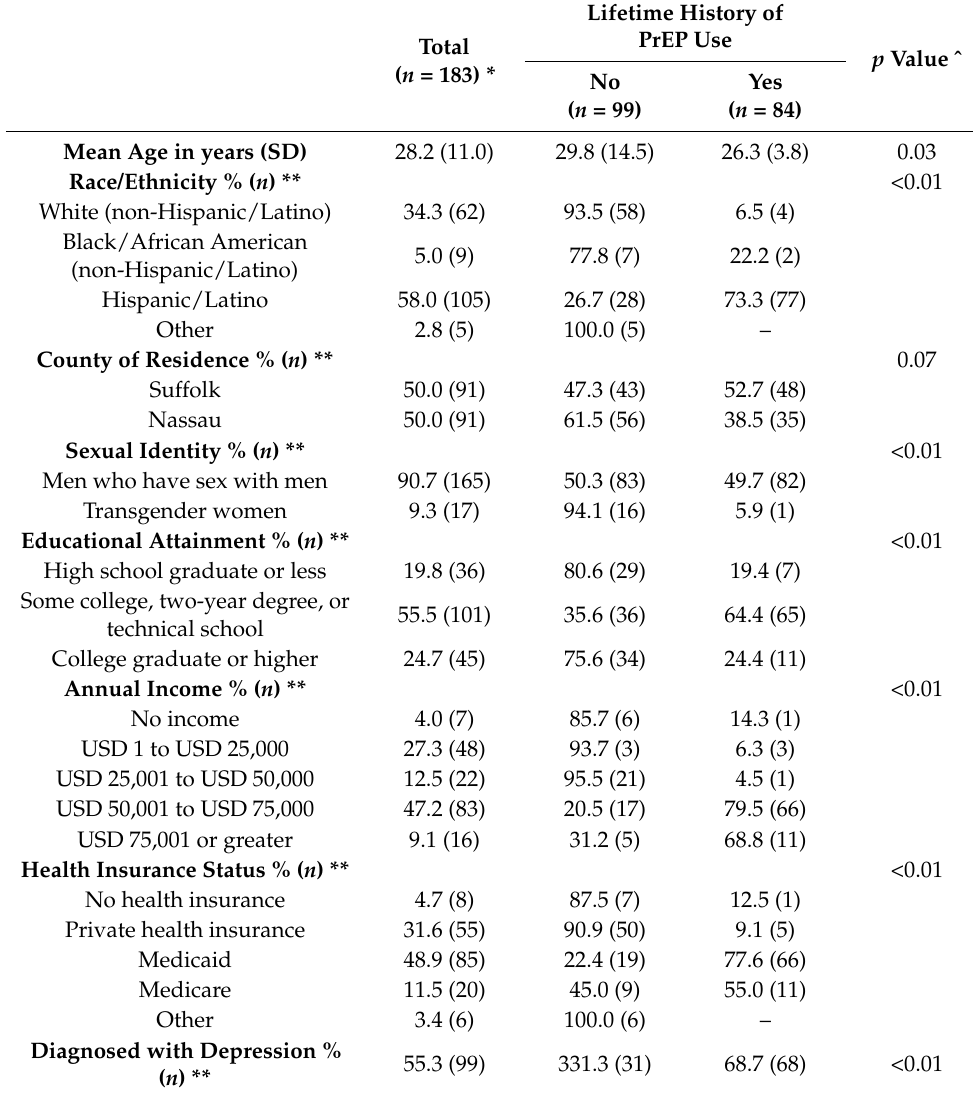
Table 1. Demographic characteristics of a community-based sample of cisgender men and transgender women who have sex with men residing on Long Island, stratified by lifetime history of pre-exposure prophylaxis (PrEP) use,